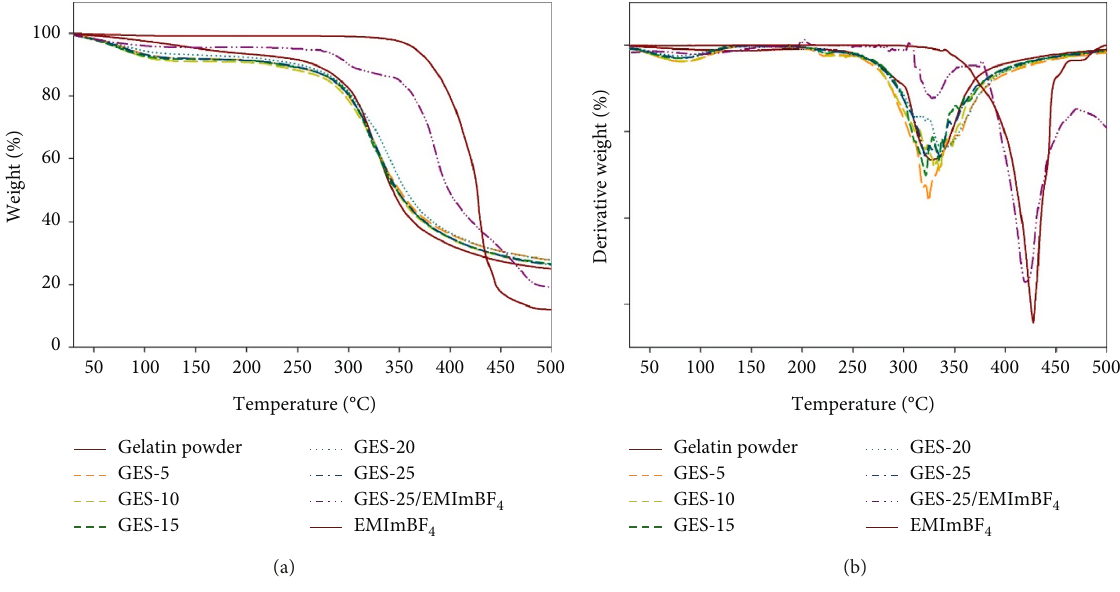
Figure 2: (a) TGA and (b) DTG thermograms of gelatin powder, GES products, GES-25/EMImBF